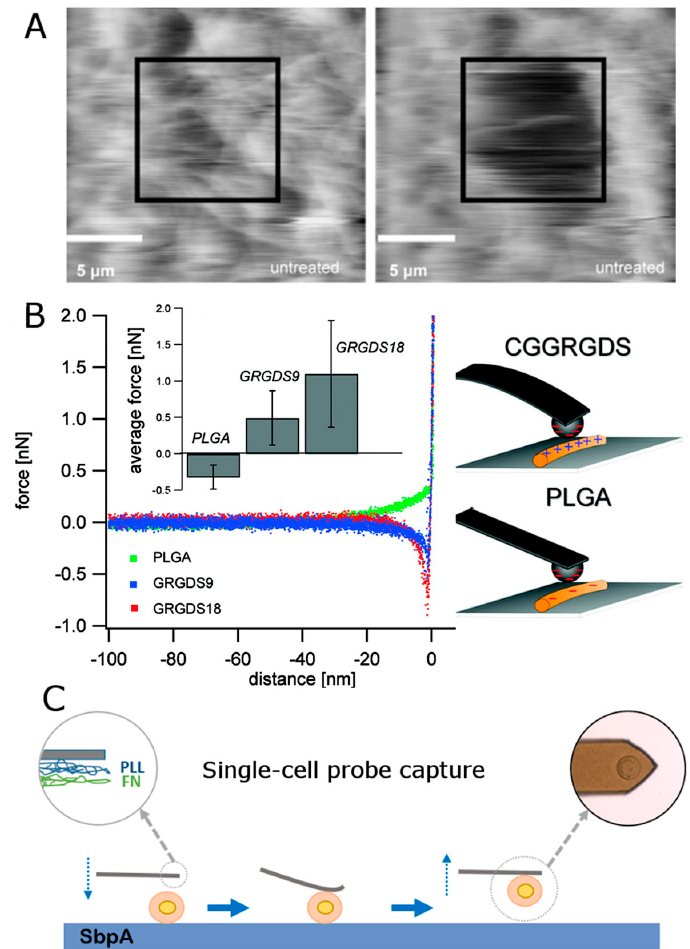
Figure 3. ( A ) Topographic scanning of collagen fibrils before (left) and after (right) scanning a 10 μ m × 10 μ m area at 5 nN. Scale bar represents 5 μ m. Black boxes indicate the region where the